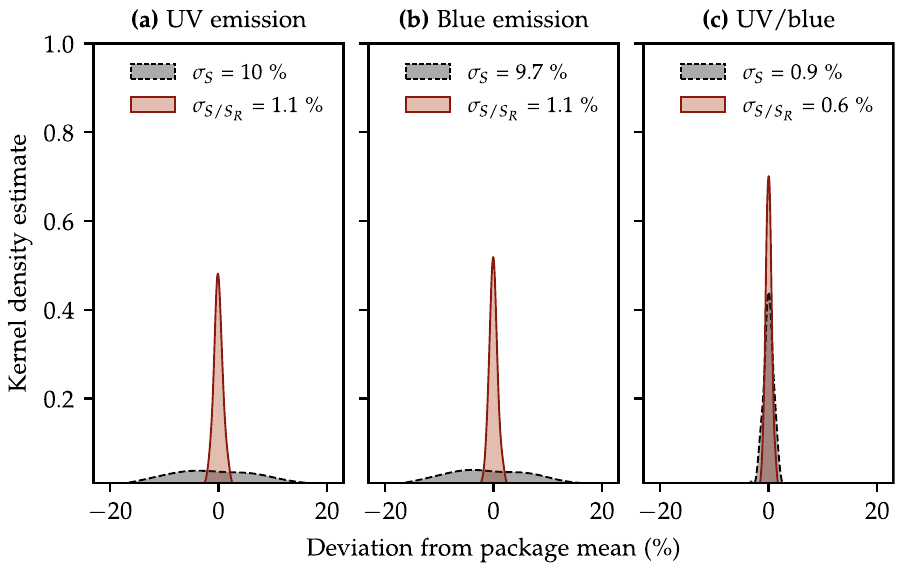
Figure 2. The kernel density estimates of 150 OSLDs plotted as the deviation of each OSLD from the mean of its package. The dashed black line denotes the distribution where the OSLD signal S with spread σ S is not corrected using the reference irradiation S R . The red solid line denotes the reference-corrected quantity S / S R with spread σ S / S . R